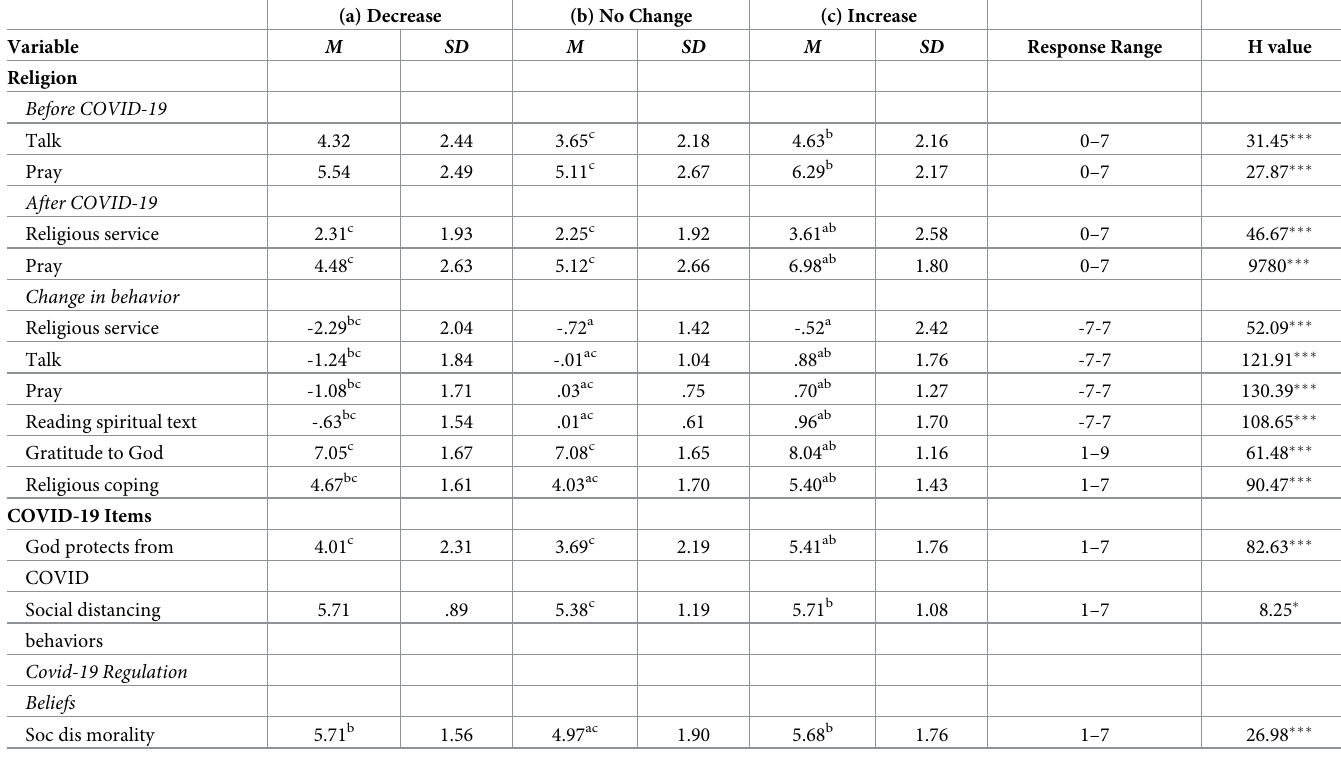
Table 2. Non-parametric test results for variables that violated normality